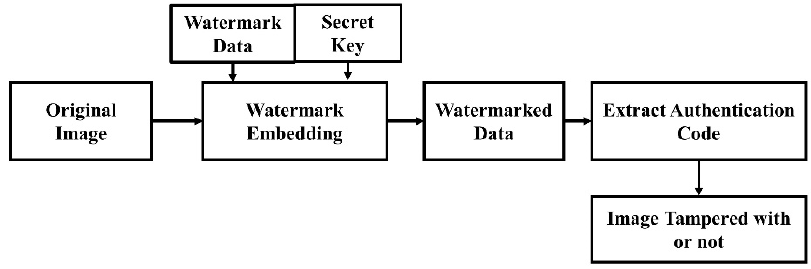
Figure 6. Content authentication and integrity verification.